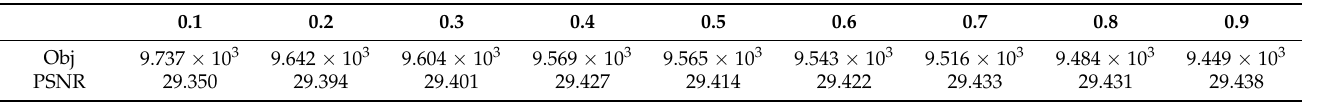
Table 3. Objective function values and PSNR values of IPGM models with different inertia parameters under the constraint of convex